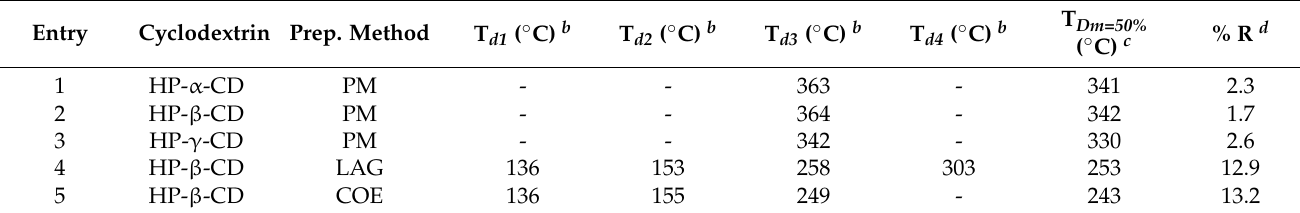
Table 2. Thermogravimetric data for iodine–cyclodextrin complexes a